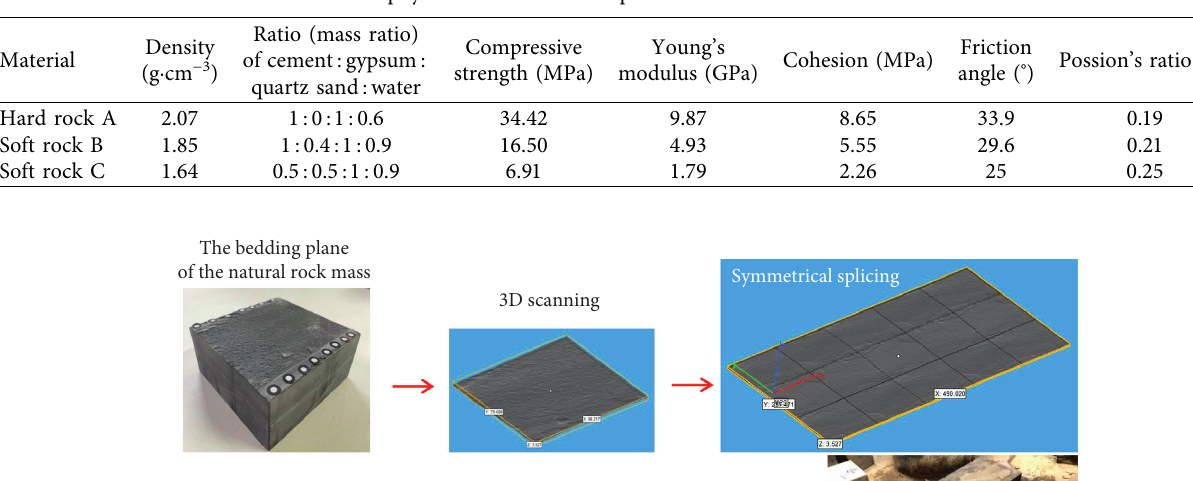
Table 1: The physical and mechanical parameters of the soft and hard rocks.